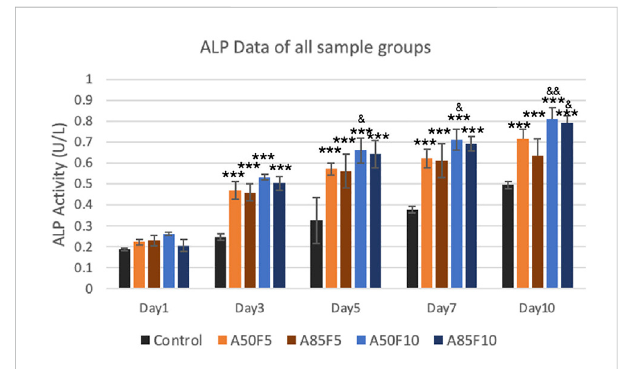
FIGURE 11 Surface modi fi ed samples of allylamine and fi bronectin disks illustrated the increased ALP enzyme activity from day 1 to day 7 (Signi fi cant difference compared with control is indicated with *, p < 0.05, **, p < 0.005, and ***, p < 0.001 while # symbol for comparing with A50F5, & symbol is applied for comparing with